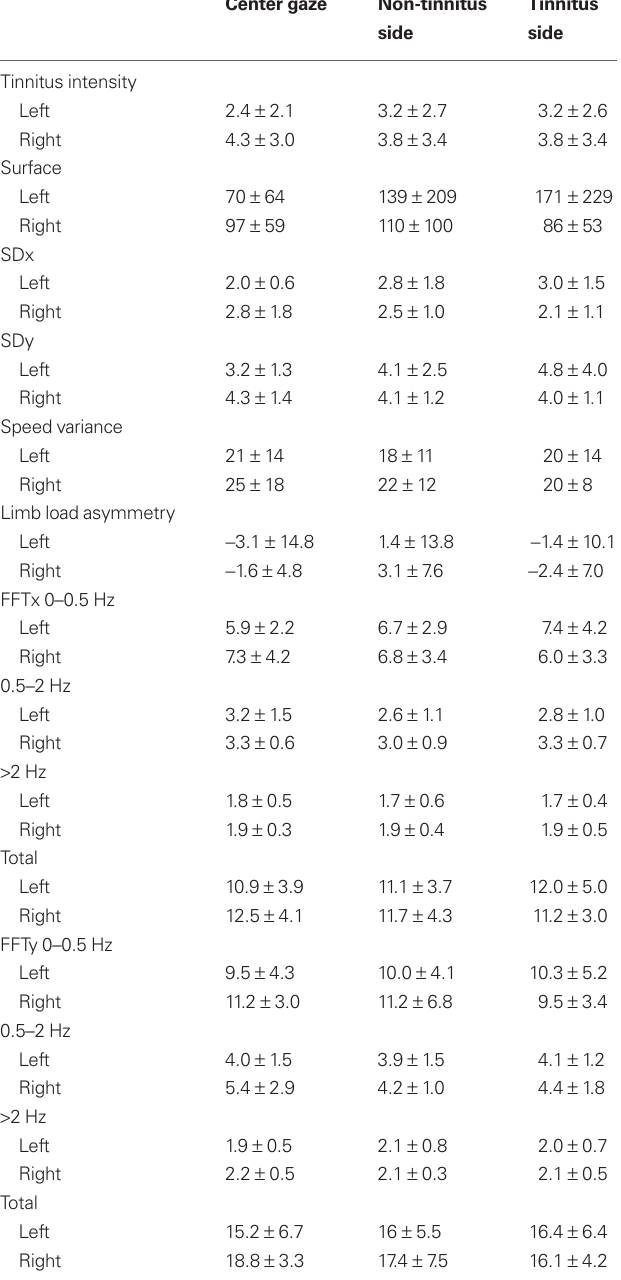
Table 3 | Group mean values for each parameter of posturography according to gaze